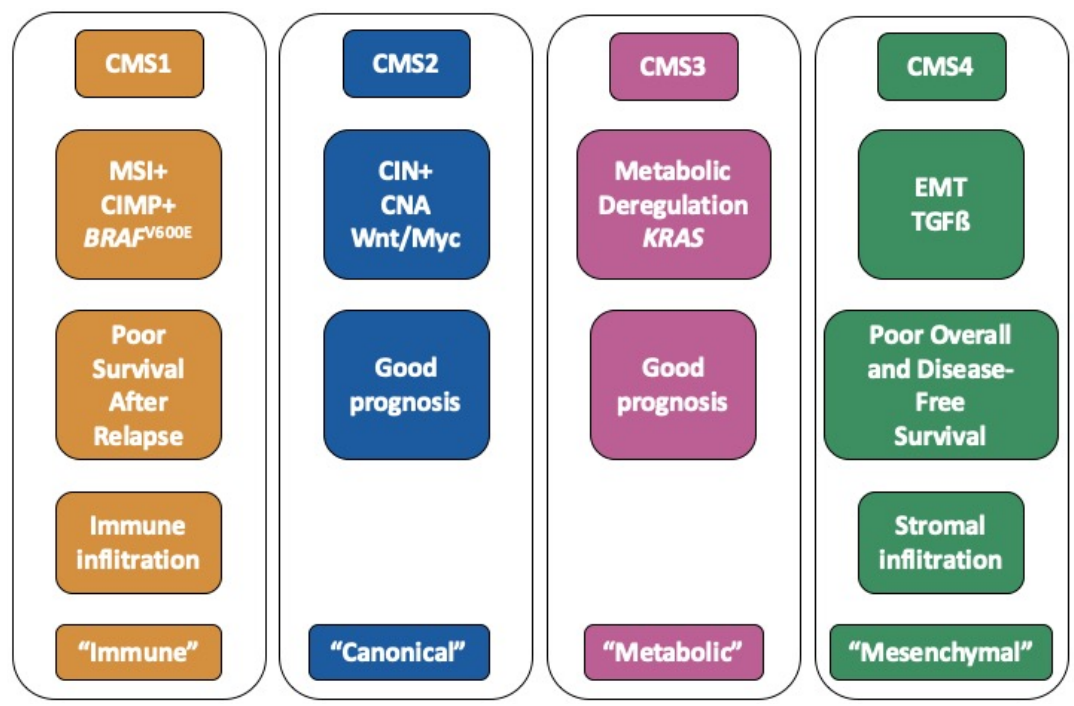
Figure 1. Summary of the hallmarks of each consensus molecular subtypes (CMS) subgroup.